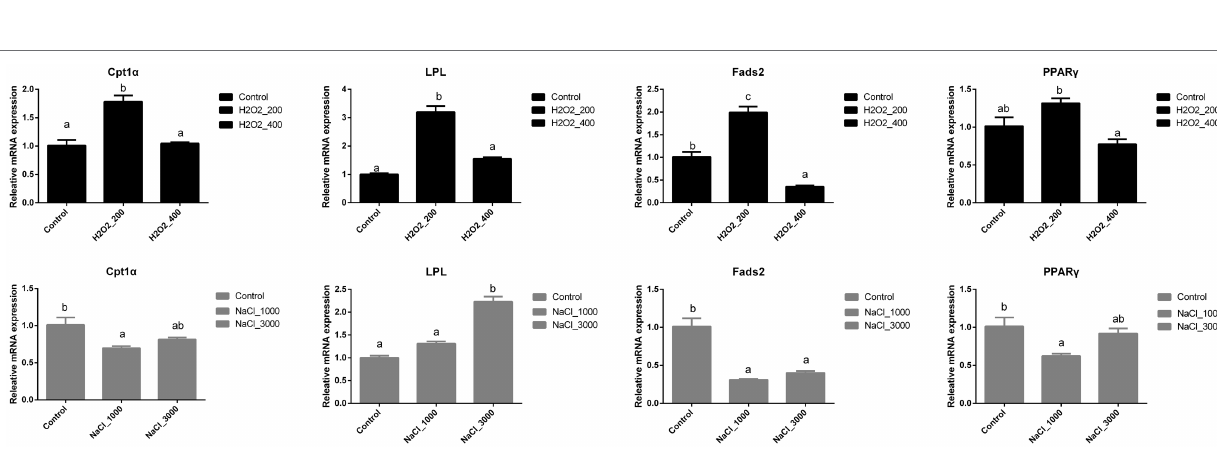
FIGURE 5 | Effects of H 2 O 2 (200, 400 mg/ml) and NaCl (1,000, 3,000 mg/ml) pre-treatment during egg hatching on the relative expression levels of genes involving lipid metabolism, including Cpt1 α , LPL, Fads2, and PPAR γ in loach